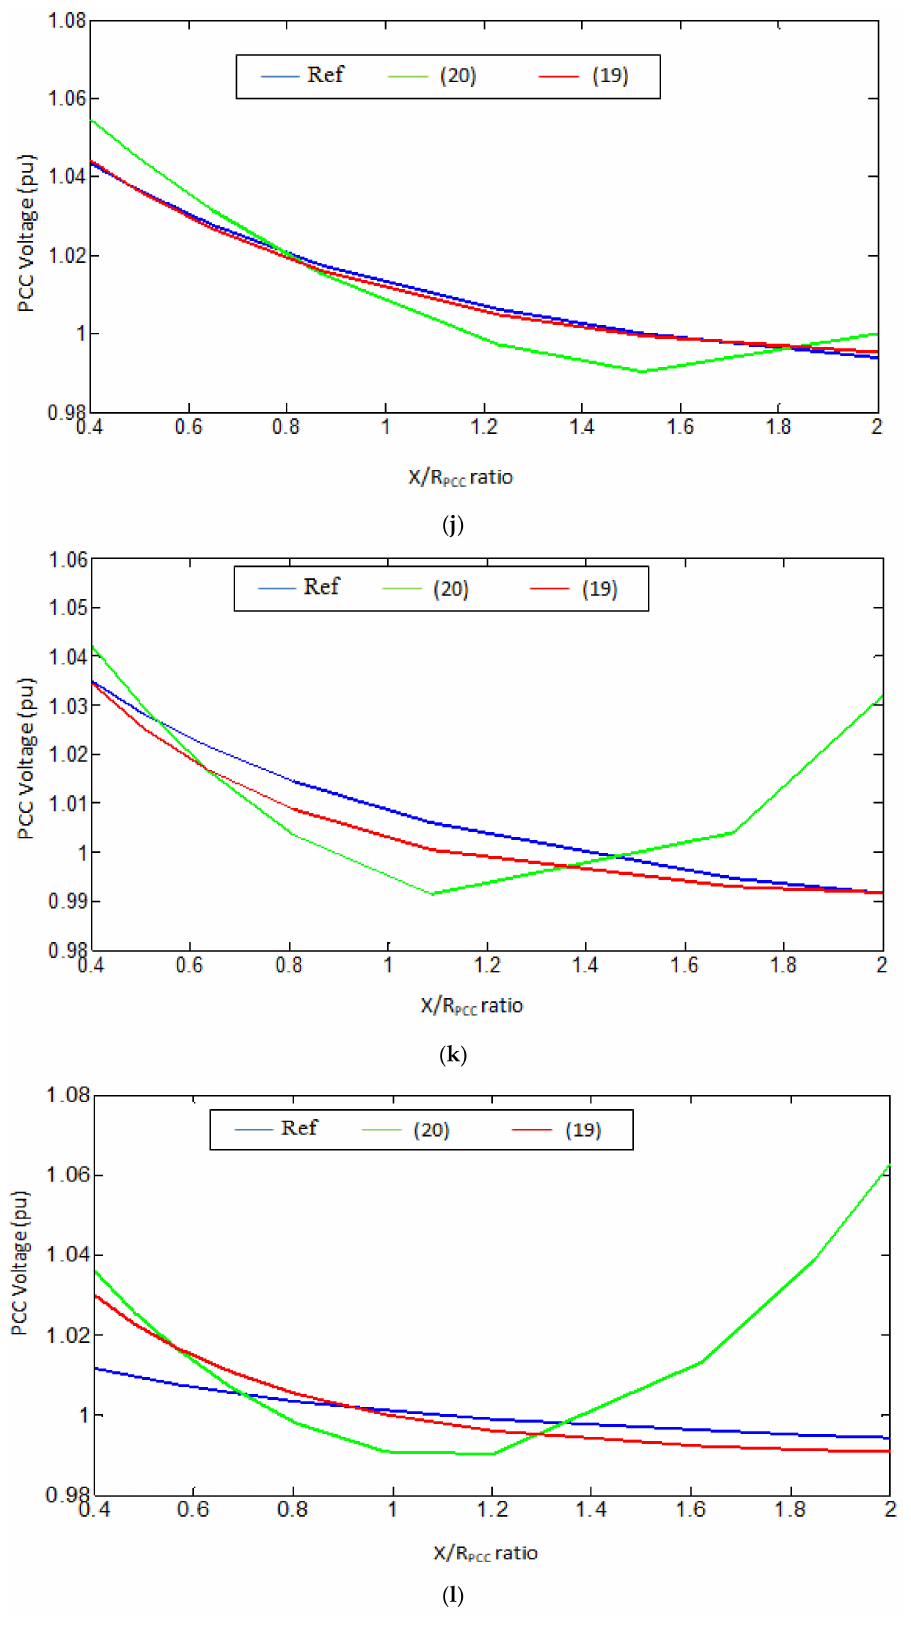
Figure 6. V PCC -X / R PCC characteristics plotted by the developed alternative equations. ( a ) V PCC -X / R PCC curves obtained by (15) and (16) for Test 1; ( b ) V PCC -X / R PCC curves obtained by (15) and (16) for Test